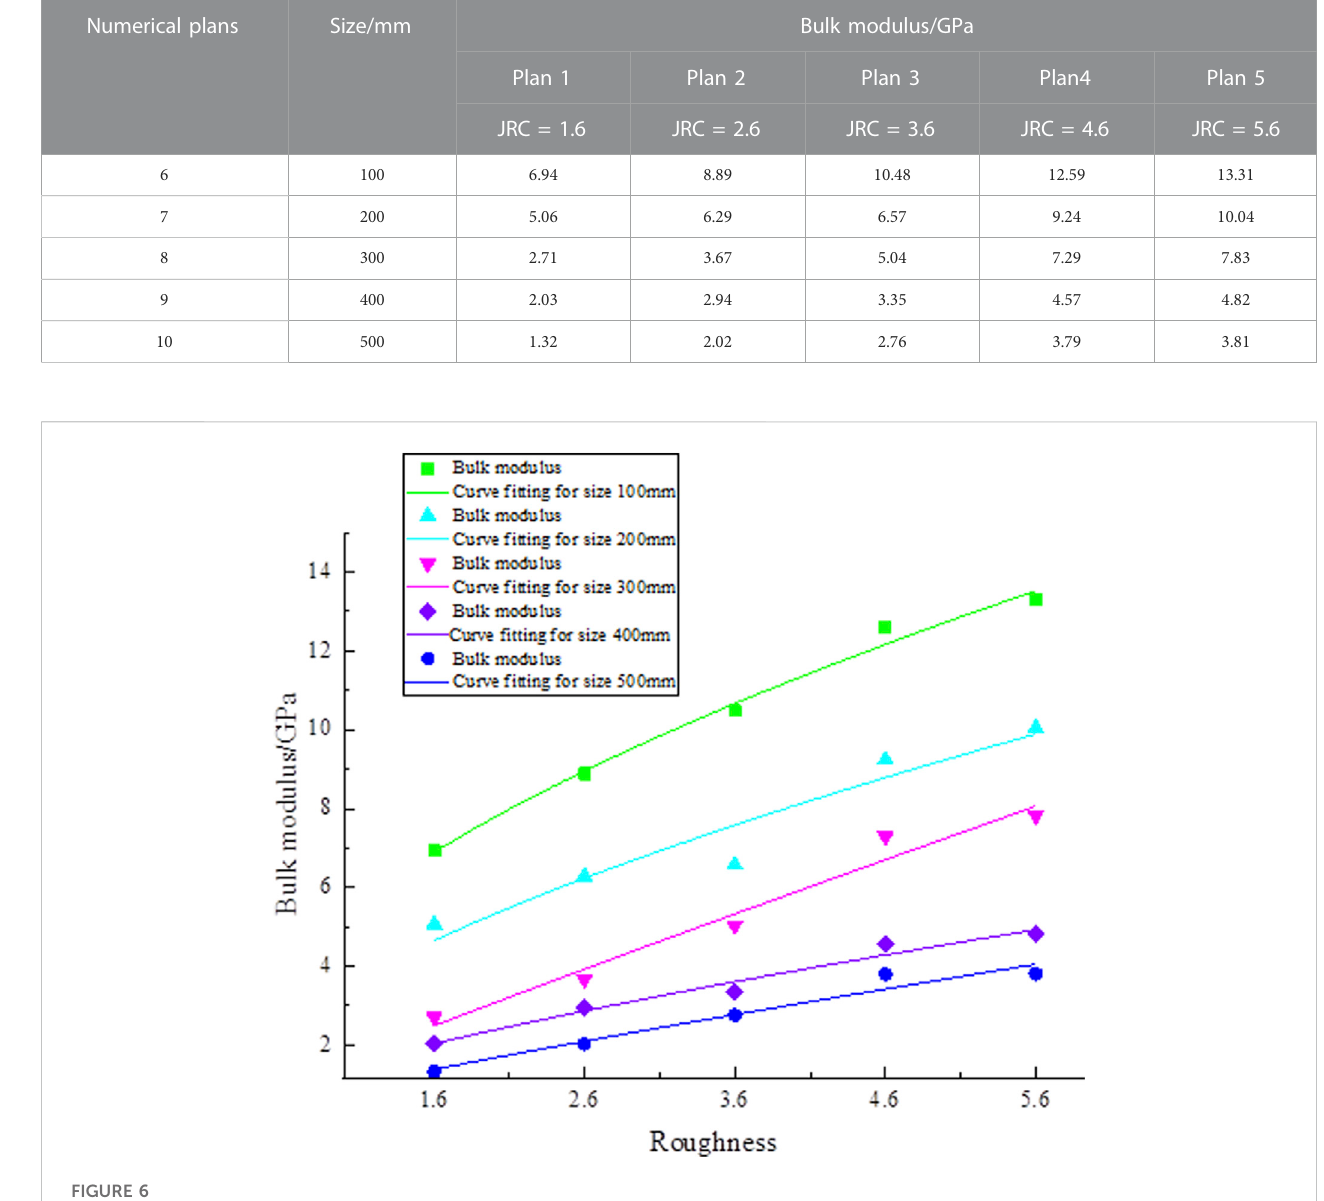
FIGURE 6 Fitting curves of bulk modulus and